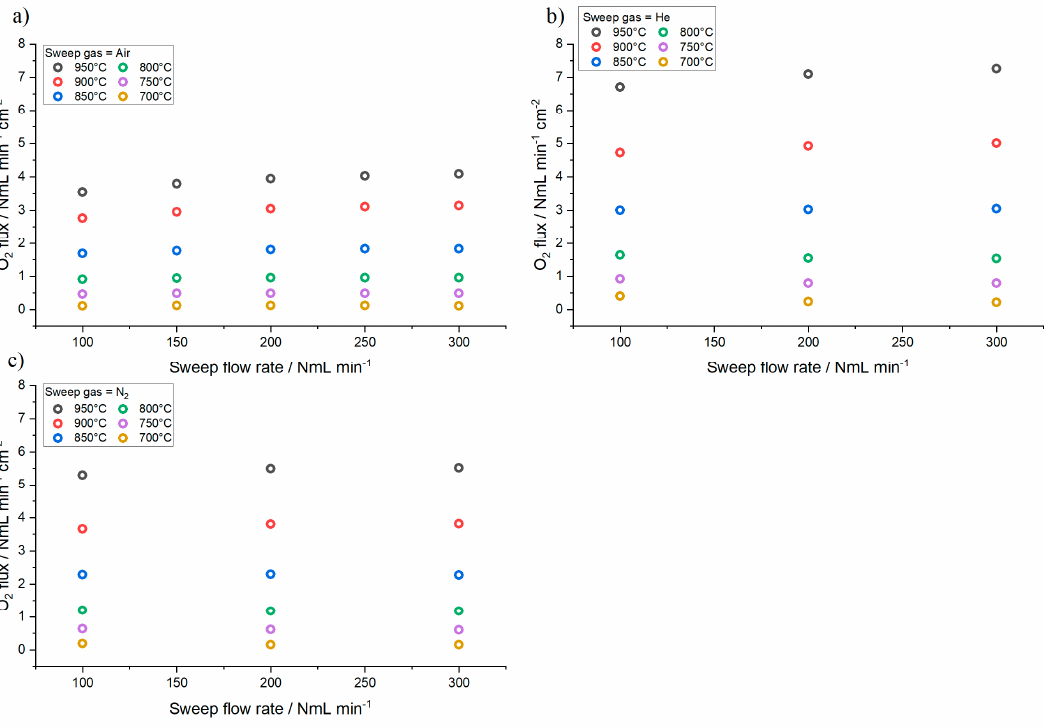
Figure 7. Measured oxygen flux as a function of the sweep gas flow rate for different temperature. Permeation tests performed by: ( a ) feeding air as process gas (N 2 = 197.5 NmL min − 1 , O 2 = 52.5 NmL min − 1 ) and helium as sweep; ( b ) pure oxygen as process gas (O 2 = 200 NmL min − 1 ) and helium as sweep; ( c ) or nitrogen as sweep gas.